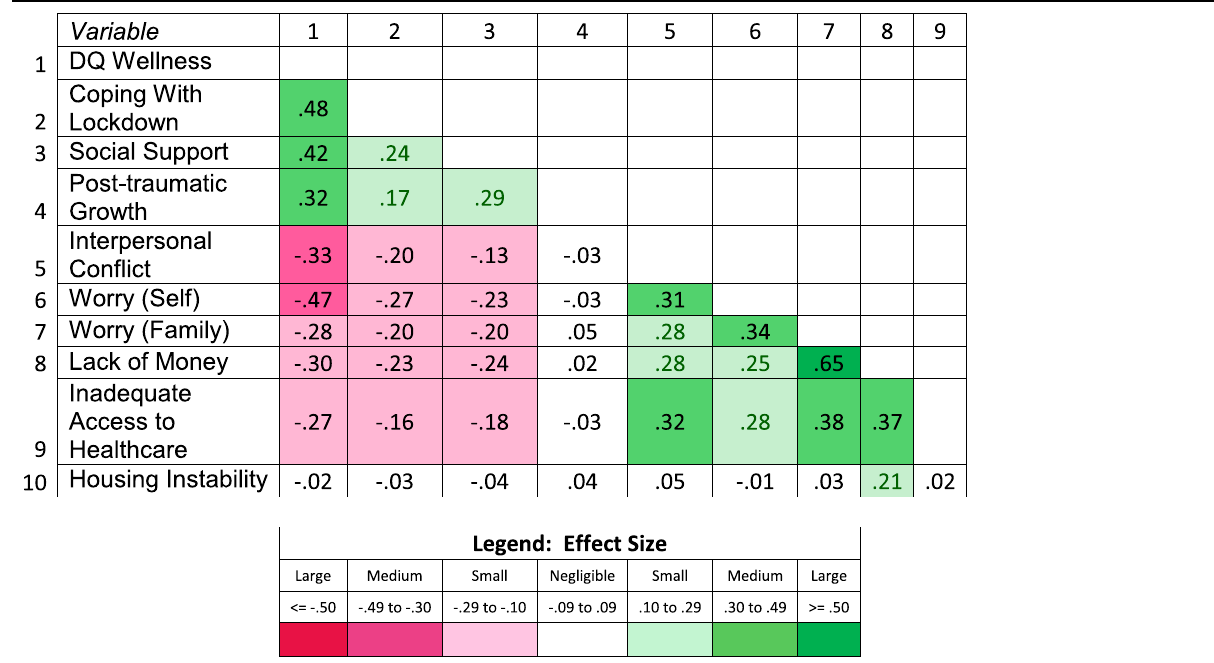
Table 3 Intercorrelations of DQ Wellness and COVID-Specific Variables